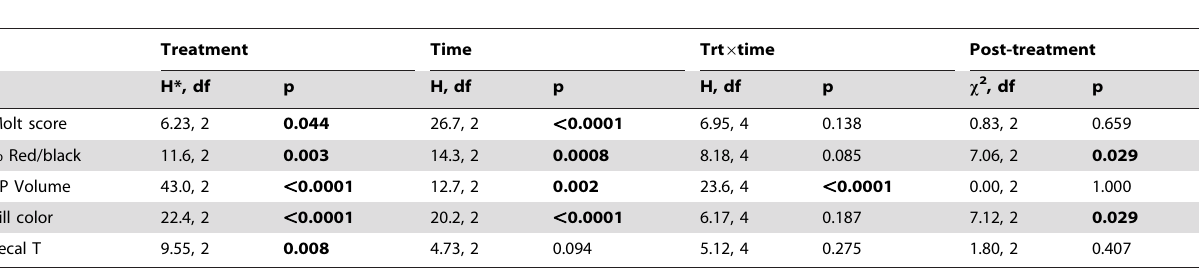
Table 1. Effects of treatment (T, control, ASY), time since implantation (capture periods; implantation, mid-treatment recapture, and implant-removal), the interaction between treatment and time, and the long-term, within season consequences of treatment measured at the post-treatment recapture on male plumage characteristics, morphology, and excreted